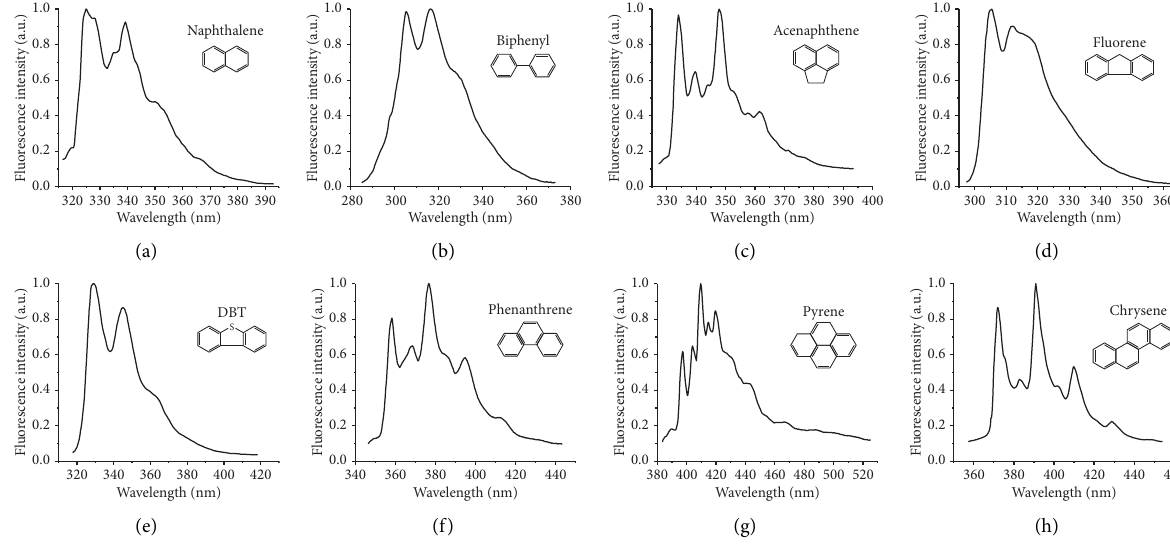
Figure 3: Fluorescence spectra of the individual AHs obtained from the